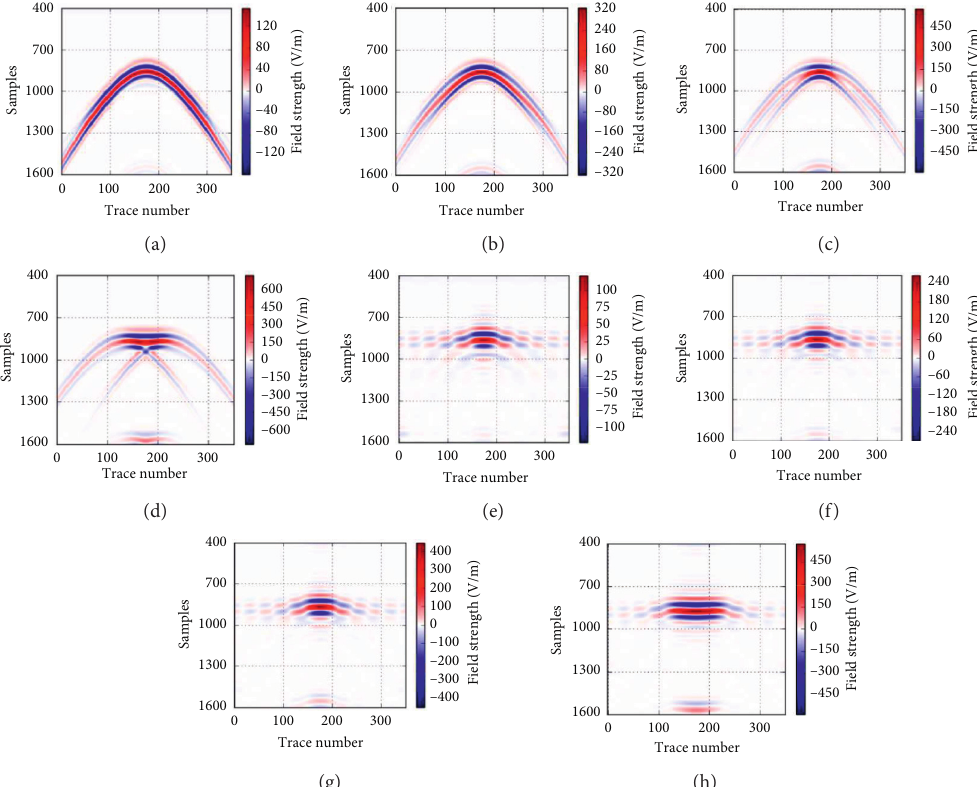
� 3cm; (b) forward result, l � 5 cm; (c) forward result, l � 8cm; v v v